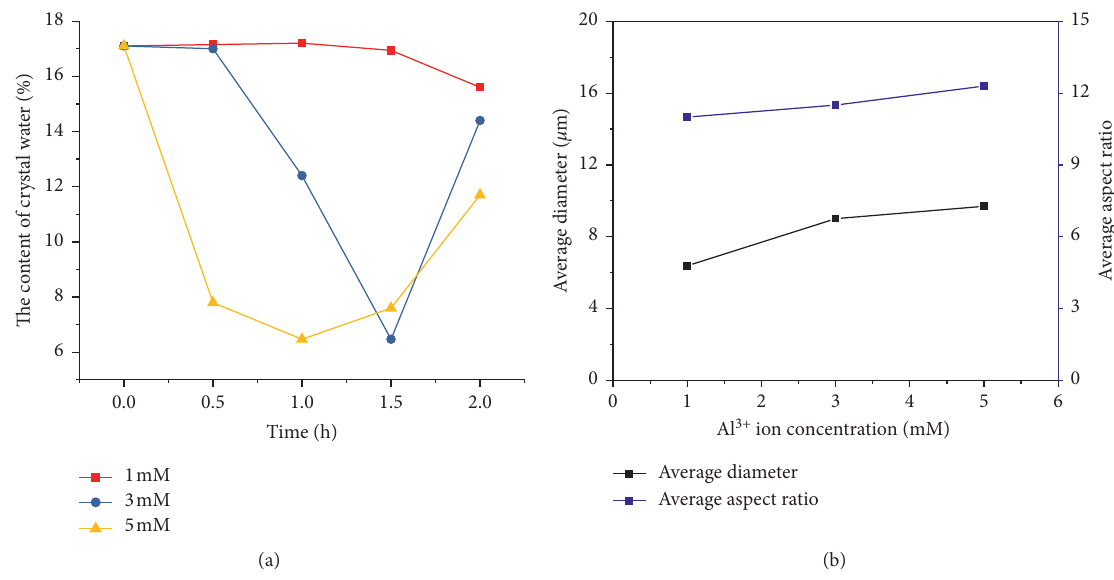
Figure 4: Changes in crystal water content at a heating temperature of 100 ° C when aluminum ion dosage was 1 mM, 3 mM, and 5mM for 2 h (a). The average aspect ratio and average diameter of calcium sulfate hemihydrate crystal (b) at a heating temperature of 100 ° C when aluminum ion dosage and heating time were 1mM for 2h; 3mM for 1.5h; and 5 mM for 1h.